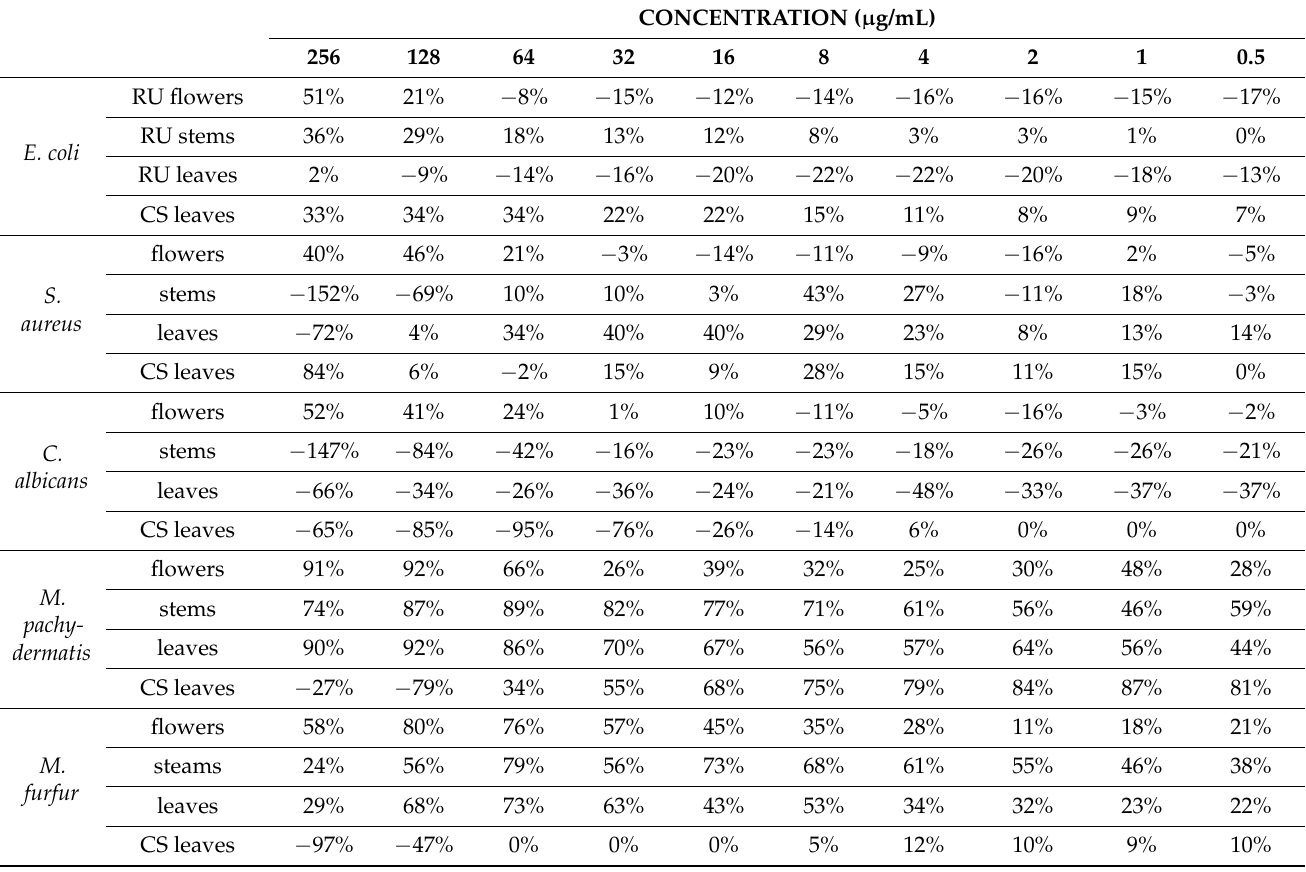
Table 3. % OD of freeze-dried extracts of R. usambarensis aerial parts and C. sinensis leaves.